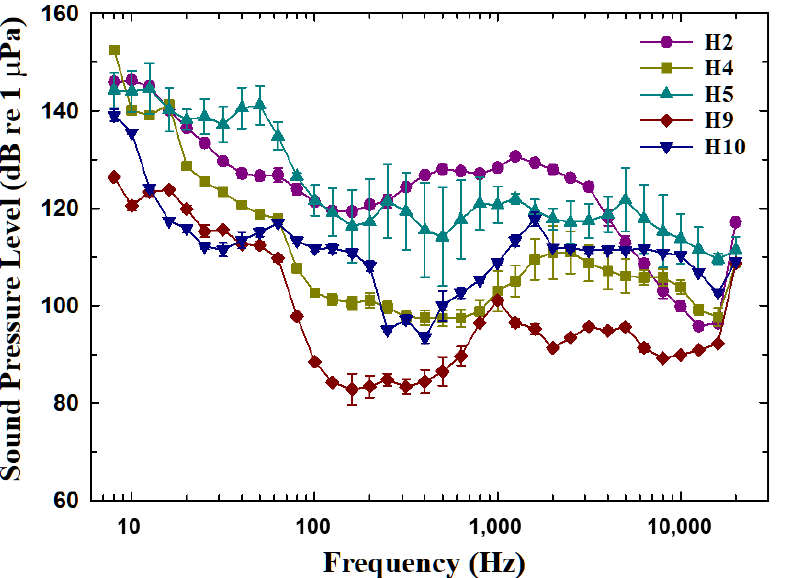
Figure 5. Sound pressure level versus ⅓ octave band frequency in riffles. The error bars illustrate the standard deviation of the obtained average. Table 2. Equivalent noise level of the surveyed habitat types.